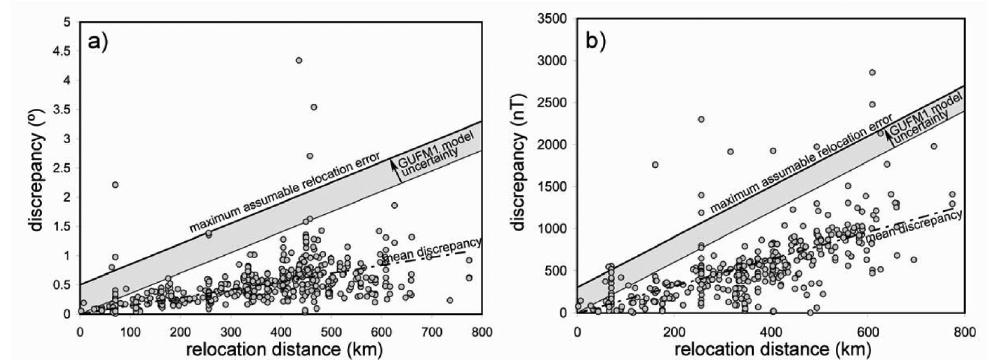
Fig. 5 . Angular (a) and intensity (b) discrepancy between relocated data from the Italian catalogue and GUFM1 values at Viterbo as a function of relocation distance. Shifted line of maximum assumable relocation error has been plotted to identify anomalous